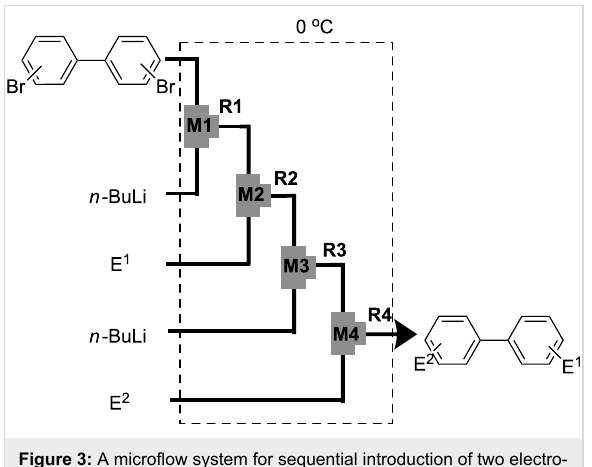
Figure 3: A microflow system for sequential introduction of two electro- philes. T-shaped micromixer: M1 (ø = 250 μm), M2 (ø = 500 μm), M3 (ø = 500 μm), and M4 (ø = 500 μm), microtube reactor: R1 (ø = 500 μm, l = 3.5 cm ( t R : 0.057 s)), R2 (ø = 1000 μm, l = 200 cm ( t R : 9.8 s)),